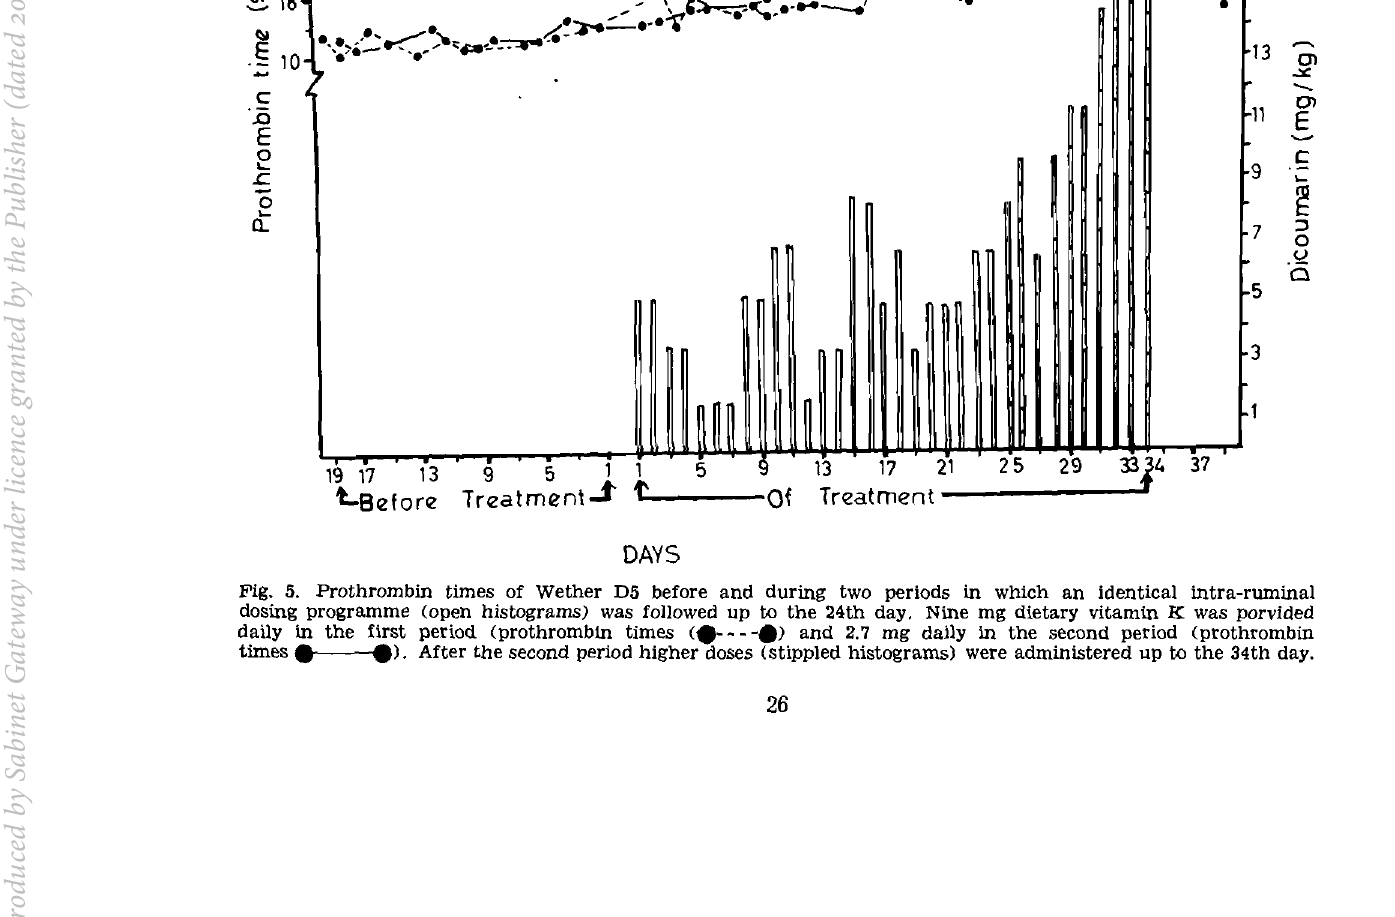
Fig. 5. Prothrombin times of Wether D5 before and during two periods in which an identical intra-ruminal dosing programme (open histograms) was followed up to the 24th day. Nine mg dietary vitamin K was porvided .>. (e- ---a) daily in the first period (prothrombin times and 2.7 mg dally in the second period (prothrombin a times After the second period higher doses (stippled histograms) were administered up to the 34th